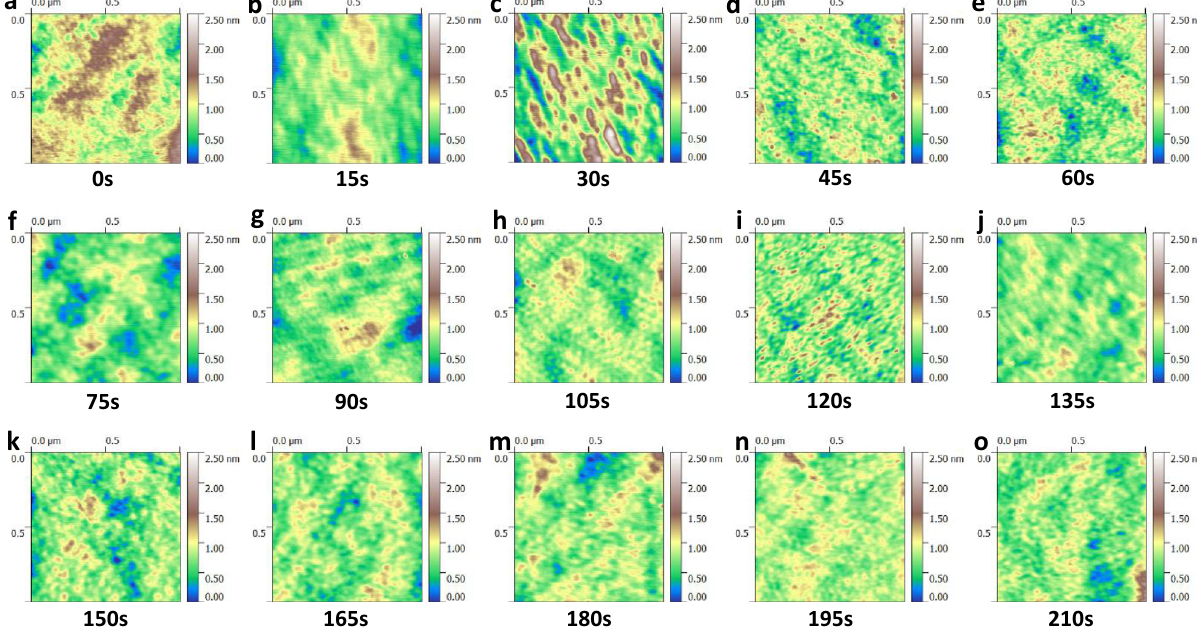
Fig. 3 Surface morphology evolution of MG with higher deposition rate. a – o are AFM images showing the surface morphology at different times. The time interval for the images is 15 s. The Zr 46 Cu 46 Al 8 fi lms deposited with a rate of 4.16 nm min − 1 at room temperature on the Si 3 N 4 substrate. The lateral size of the image is 1 μ